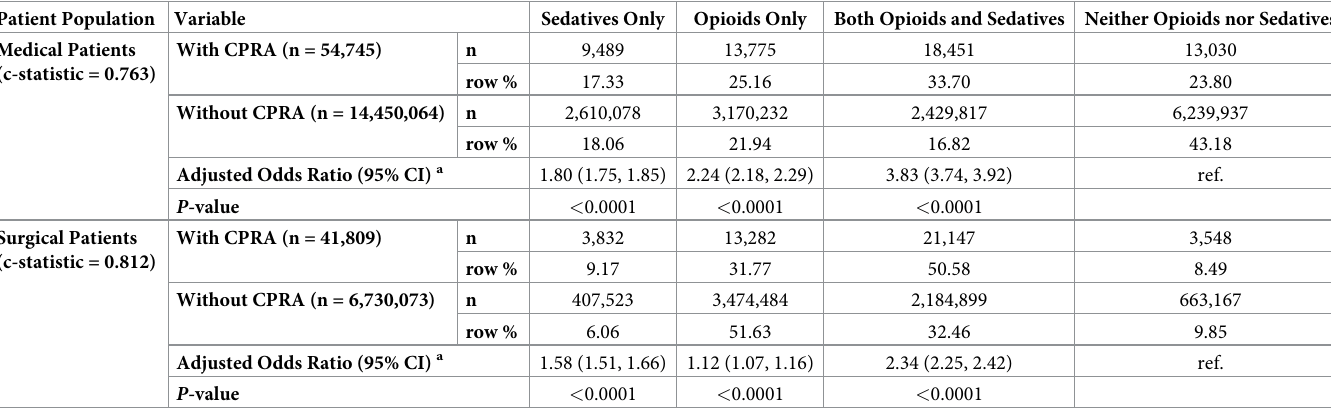
Table 2. Multivariable logistic regression analysis of the incidence of CPRA. Patient Population Variable Sedatives Only Opioids Only Both Opioids and Sedatives Neither Opioids nor Sedatives Medical Patients With CPRA (n = (c-statistic = 0.763)